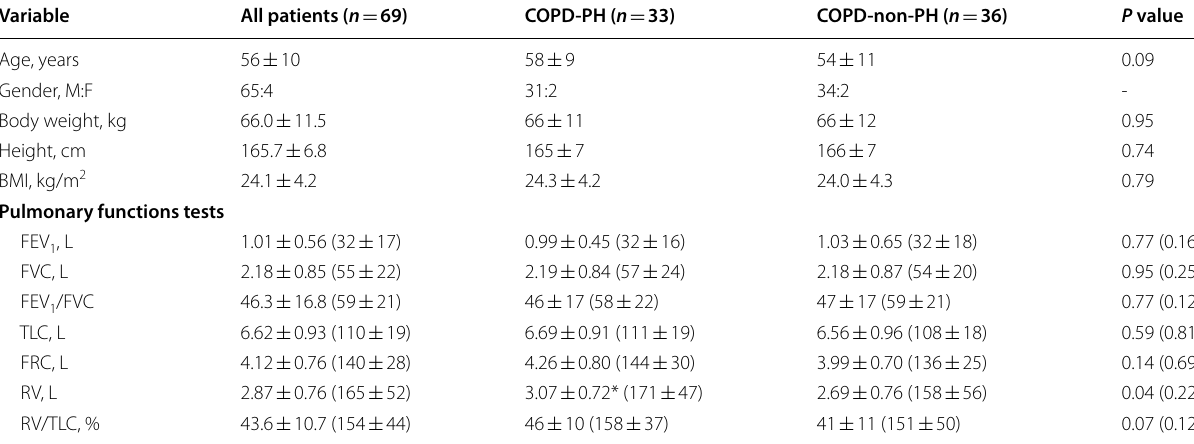
Values are means SD unless otherwise specified, values between parentheses are percentages of predicted normal ± BMI body mass index, COPD Chronic obstructive pulmonary disease, FEV 1 , forced expiratory volume in 1 s, FRC functional residual capacity, FVC forced vital capacity, PH pulmonary hypertension, RV residual volume, TLC total lung capacity * P < 0.05 COPD-PH patients vs. COPD-non-PH patients Table 2 Resting arterial blood gases and RHC‑derived data